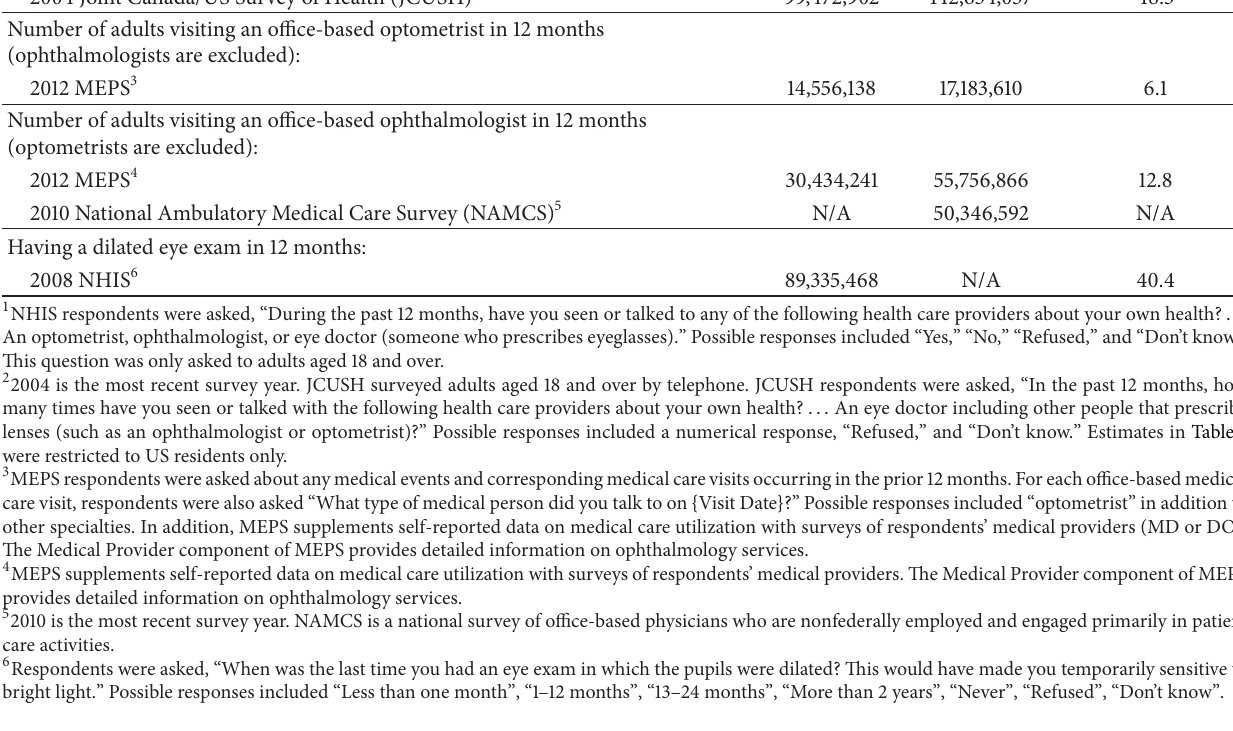
Weighted percent Weighted Weighted of adults visiting an number of number of eye care adults visits